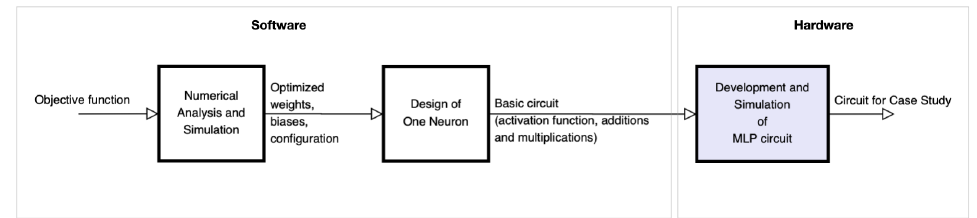
Figure 1. Block diagram of the design and development of the proposed